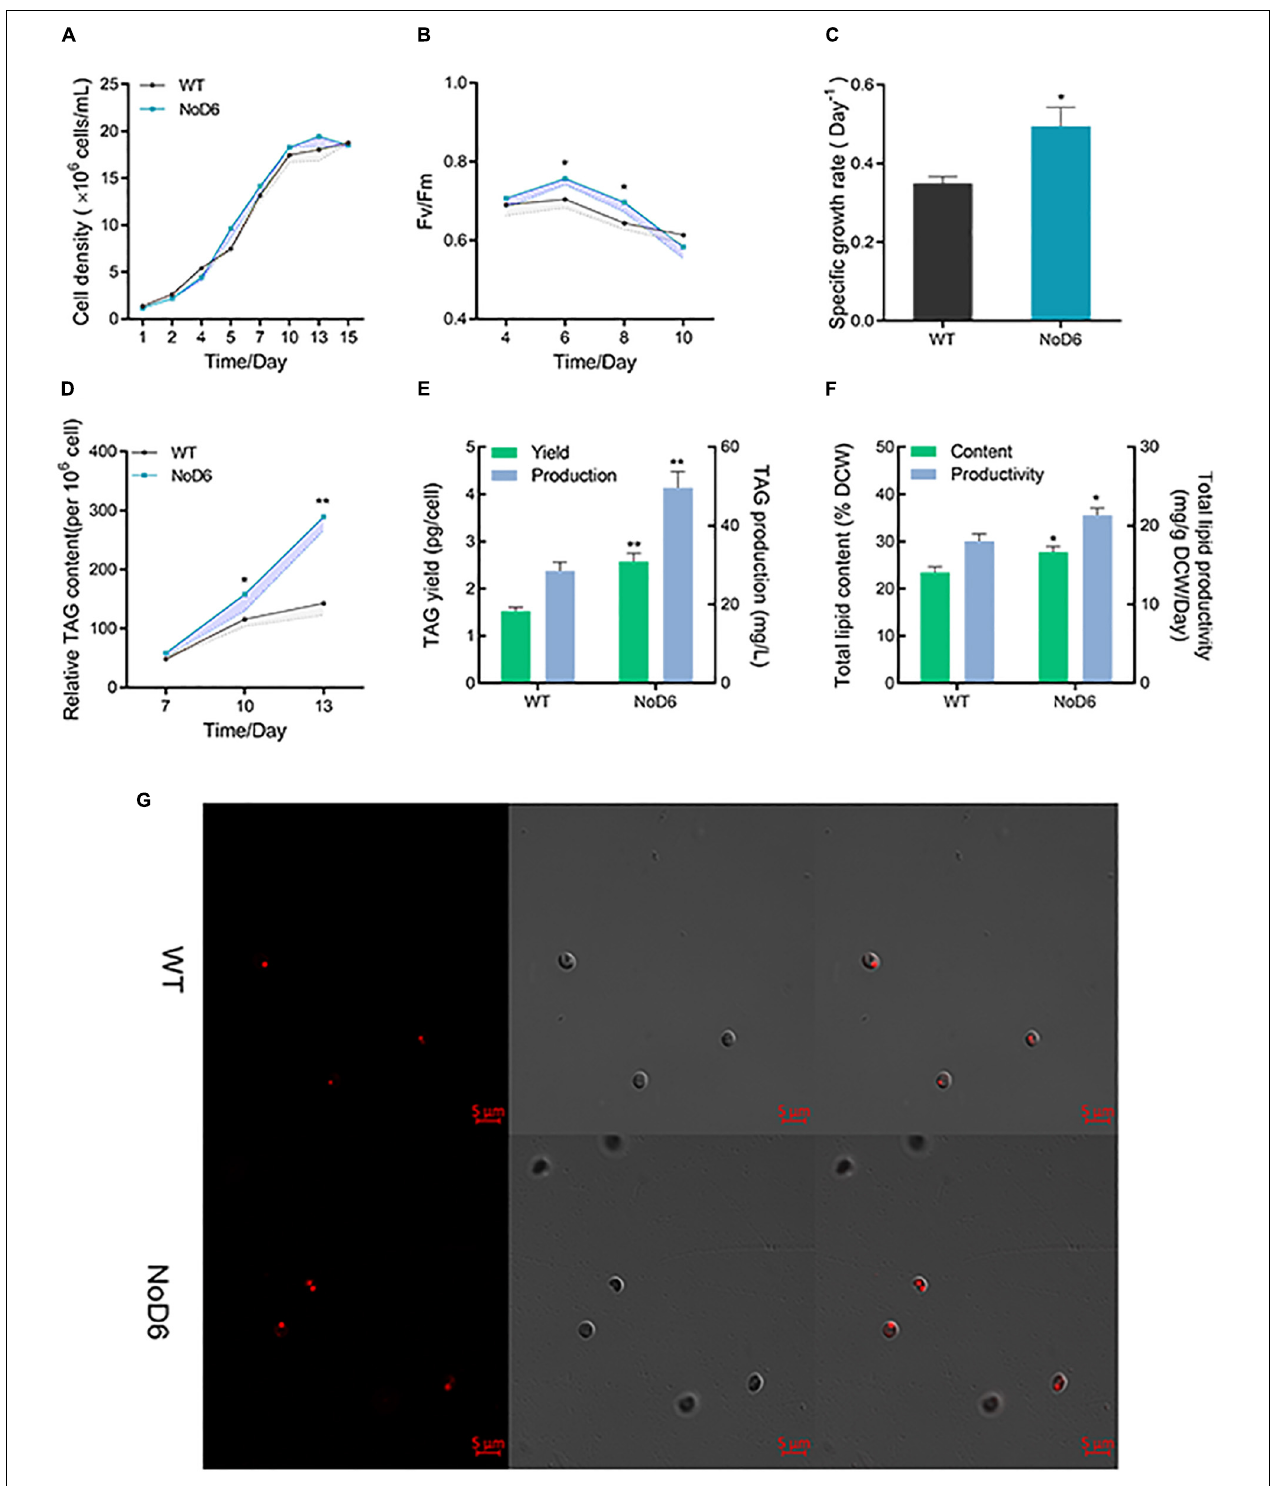
FIGURE 2 | Physiological and lipidomic analyses of transgenic cell overexpressing NoD6. (A) Growth curves of transgenic and WT as determined by direct cell count methods. (B) Photosynthetic efficiency as reflected by Fv/Fm. (C) Specific growth rate. (D) Nile-red based fluorometric lipid analysis. (E) TAG yield (pg/cell). (F) Total lipid content (% DCW). (G) Laser scanning confocal microscopic observation of Nile-red stained cells. Bars = 5 µ m. Left panel, lipid fluorescence; Middle panel, differential interference contrast (DIC); Right panel, overlay image. Significant difference is indicated at ∗ p < 0.05 or ∗∗ p < 0.01 level. Each value represents means ± SD ( n =